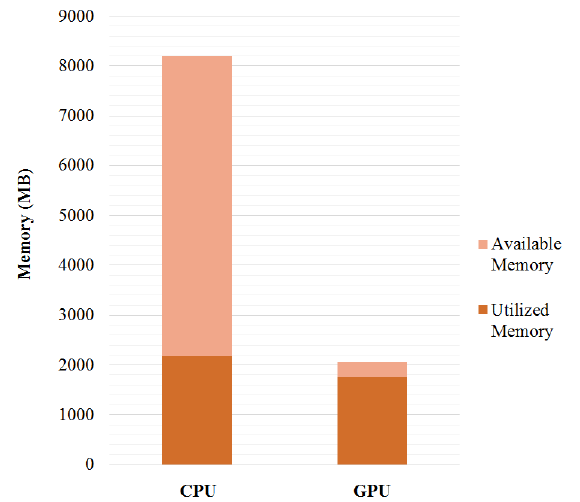
Fig. 12: Memory consumption in both implementations